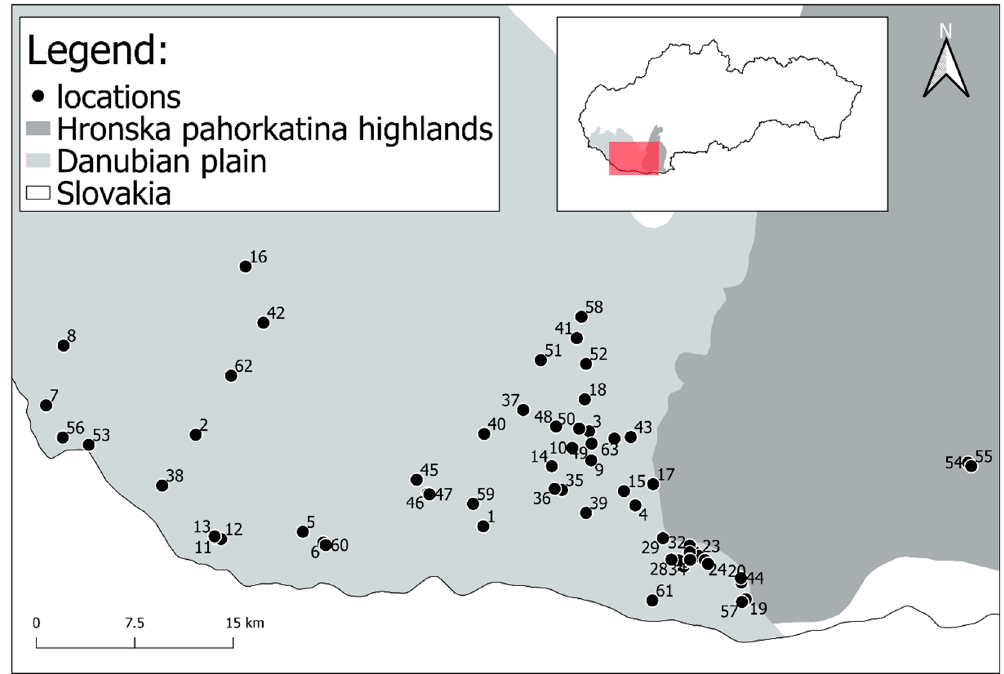
Figure 1. Localities of trapping Pannonian root vole.